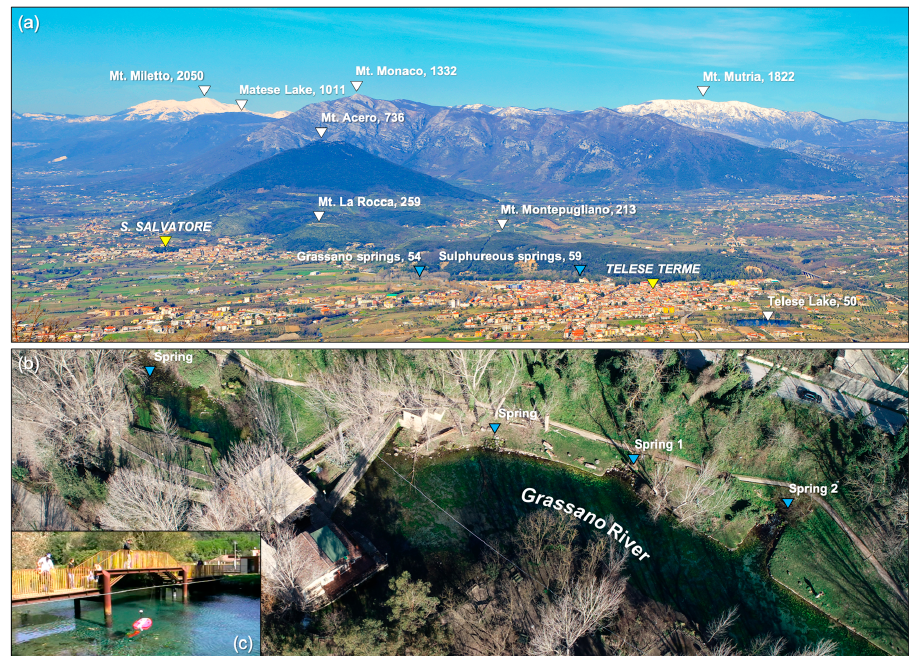
Figure 3. View of the southern side of the Matese massif ( a ) and location of the Grassano springs group ( b ). Discharge measurements of the springs have been carried out in correspondence of the bridge ( c ) using hydrometric boat with an acoustic profiler Doppler.